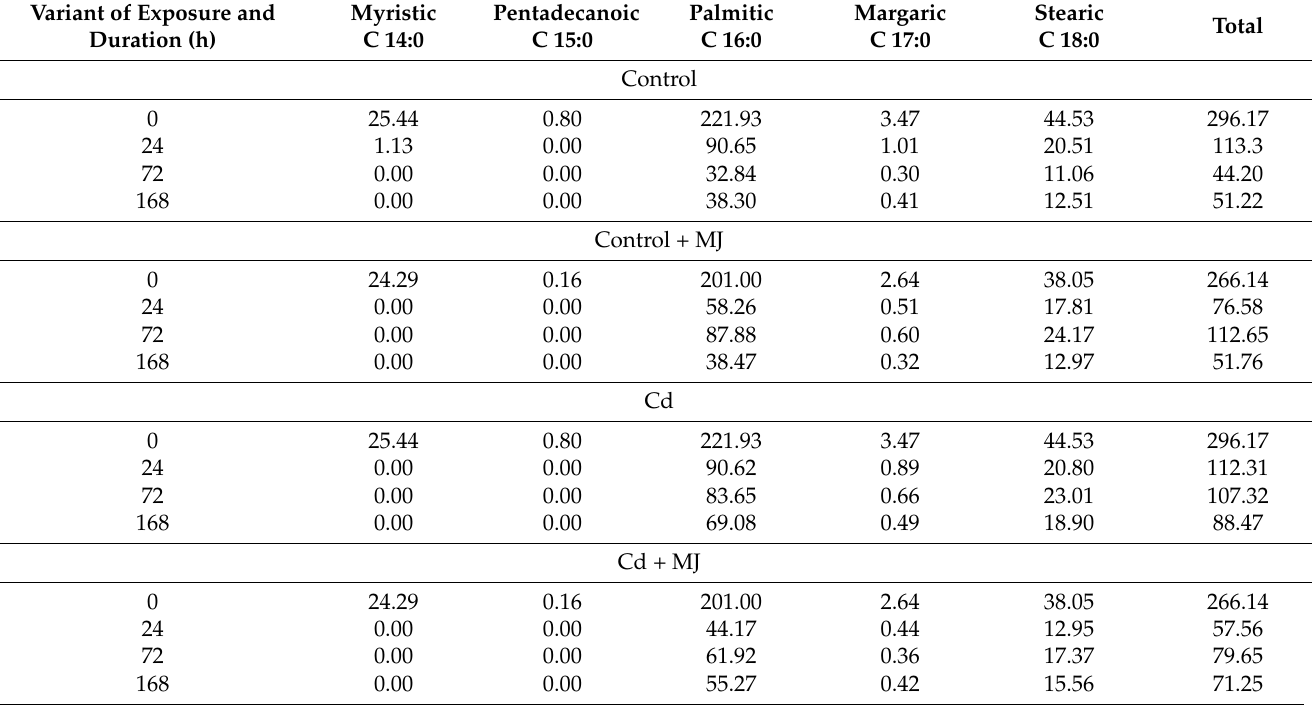
Table 5. Effect of exogenous MJ on the content of saturated FAs (mkl/mL) in wheat leaves under Cd